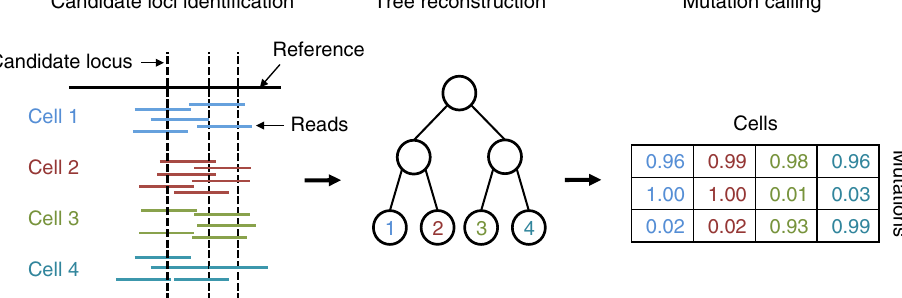
Fig. 1 Schematic overview of SCI Φ . First, candidate loci are identi fi ed. These loci are then used to infer the underlying phylogenetic tree and the parameters of the model. In a last step the mutation to cell assignment is sampled from the posterior